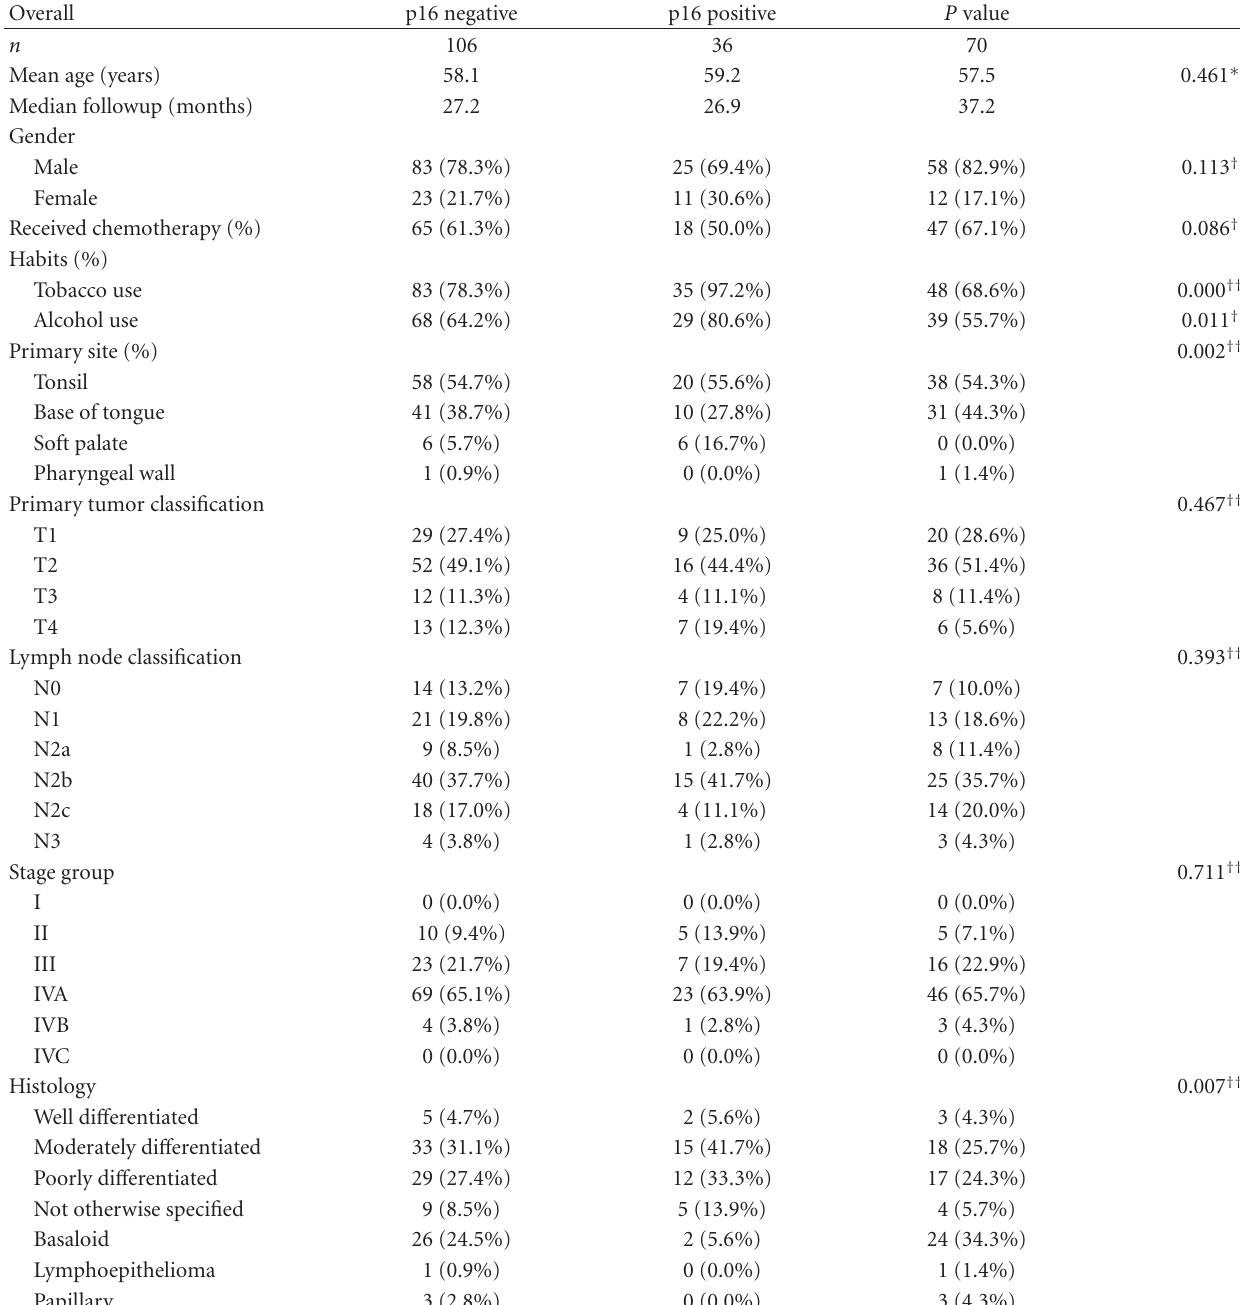
Table 2: Patient